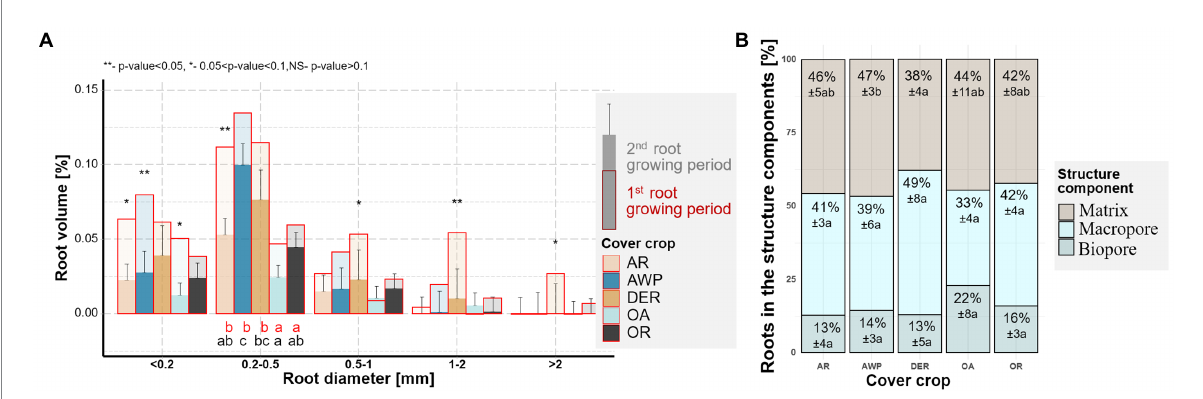
FIGURE 1 (A) Root size distribution for root volumes of the five studied cover crops after the 1st (red) and 2nd root growing period (multiple fill colors). Letters indicate significant differences between plant species within each size class for the 1st (red) and 2nd (black) growing period ( p < 0.05). Stars above the bars show significant differences between the two growing periods. Whiskers show standard error of the means for the 2nd growing period. (B) Root growth into different structural components of the soil, namely, into existing biopores (>36 μ m Ø, cylindrical shape), macropores (>36 μ m Ø), and soil matrix (no pores visible at CT resolution) during the 2nd growing period. The numbers are means ±standard errors. Letters indicate significant differences between plant species within each structural component ( p <